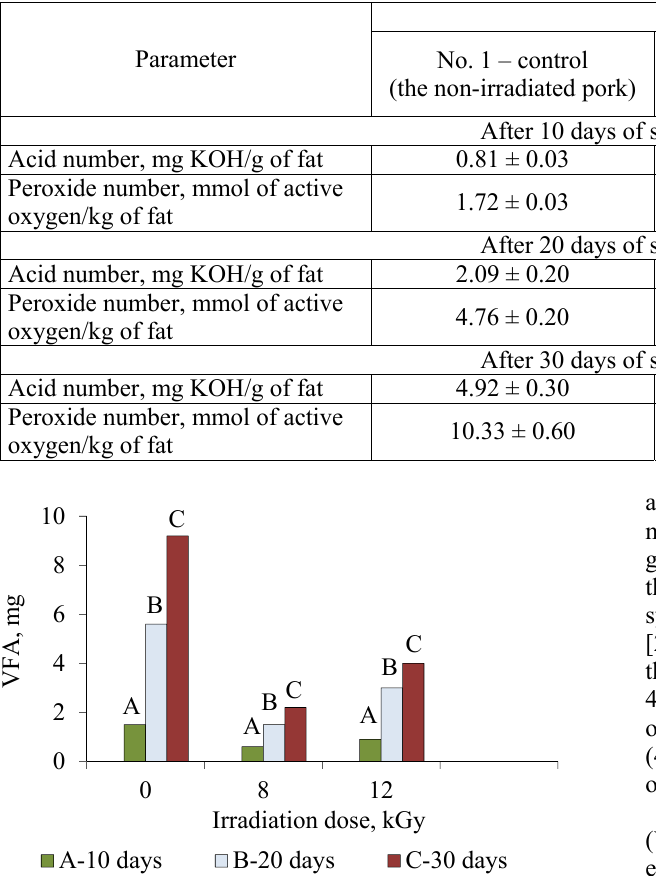
Fig. 7. Dynamics of the content of volatile fatty acids in the control and experimental samples of the refrigerated pork neck on the bone packed using MAP irradiated at different doses, mg KOH in 25 g.